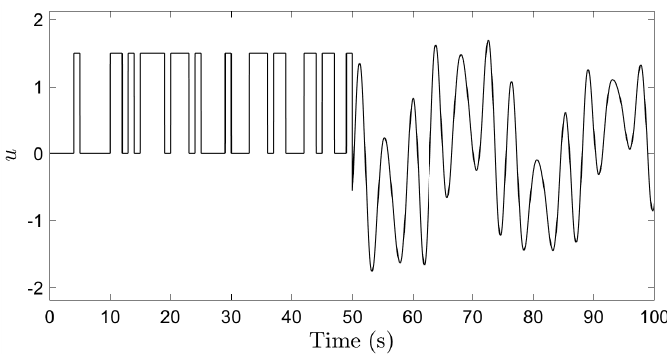
Figure 2. A special test signal for process